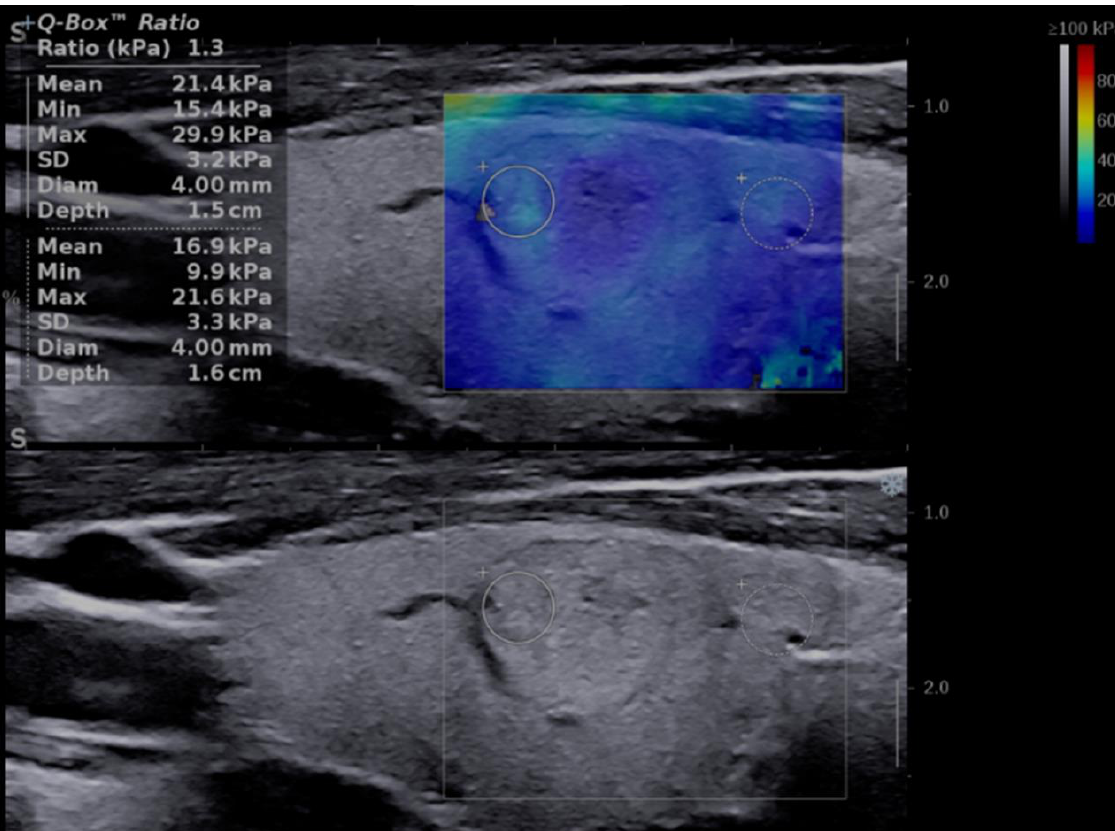
Figure 1. Transverse US scan displaying a soft thyroid nodule in the two-dimensional shear-wave elastography (2D-SWE) evaluation, first image ( up ): Mean elasticity index (EI) = 21.4 kPa, nodule-to- parenchyma QBox ratio = 1.3; and in the greyscale (2B) evaluation, second image ( down ): low-risk, isoechoic solid nodule, with a thin halo, well-defined borders, and no features of high